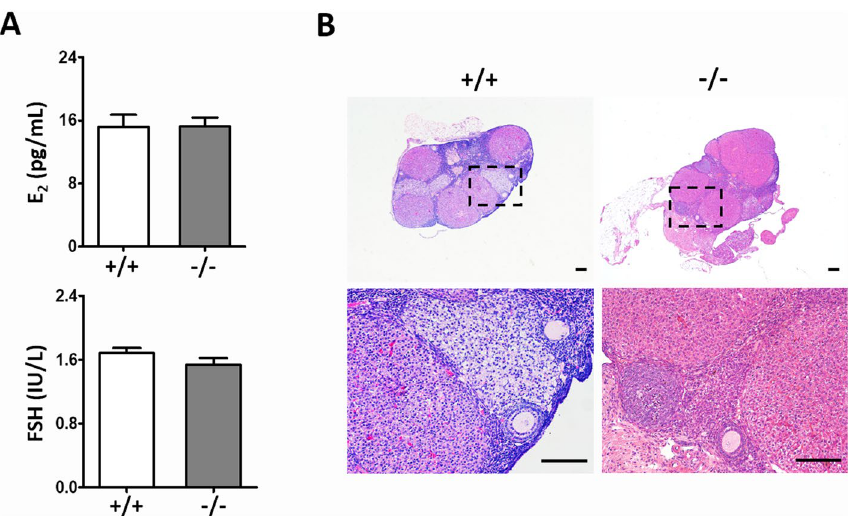
Figure 5. Hormone and ovary morphology analyses after fertility test. (A) No significant changes in FSH and E 2 concentrations in serum of 8-month-old mice between Tmem150b + / + (n = 5) and Tmem150b -/- (n = 5) group. (B) Ovarian histological analysis with H&E staining after fertility test from both genotypes. Scale bar = 100